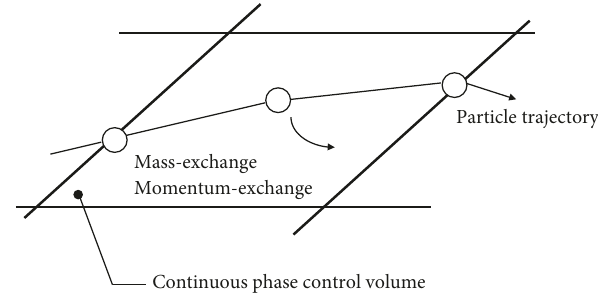
Figure 1: Two-way coupling